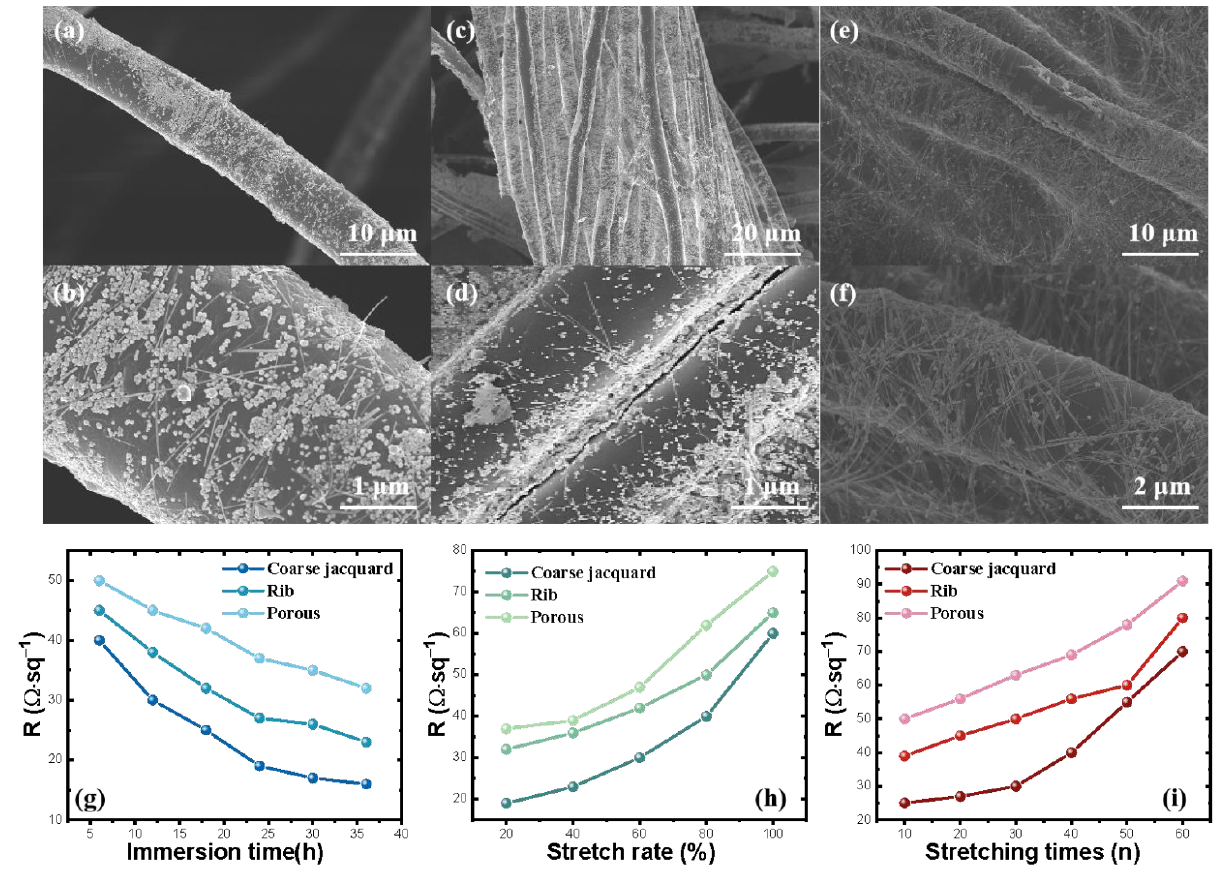
Figure 11. SEM images of conductive fabrics prepared based on the impregnation process: ( a , b ) Porous fabric; ( c , d ) Coarse jacquard fabric; ( e , f ) Rib fabric; ( g ) Plot of square resistance of conductive fabric with immersion time; ( h ) Plot of square resistance of conductive fabric with the stretch rate; ( i ) Plot of square resistance of conductive fabric with stretching times.